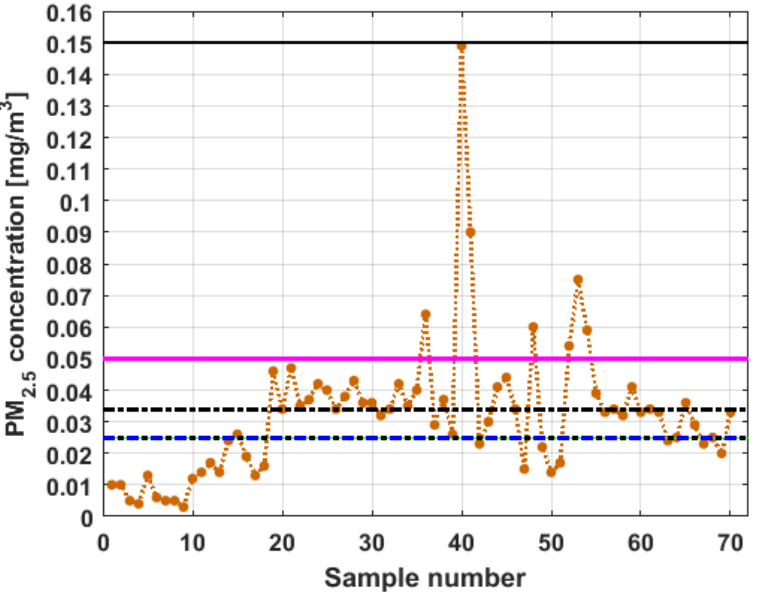
Figure 15. Observations of variable Y 2 , together with the 95% nonparametric confidence interval for the median (shown with dashed black lines) and the limits that define the categories of the level of air pollution by PM 2.5 (Desirable level: Blue line; Acceptable level: Magenta line; Caution level: Black line).